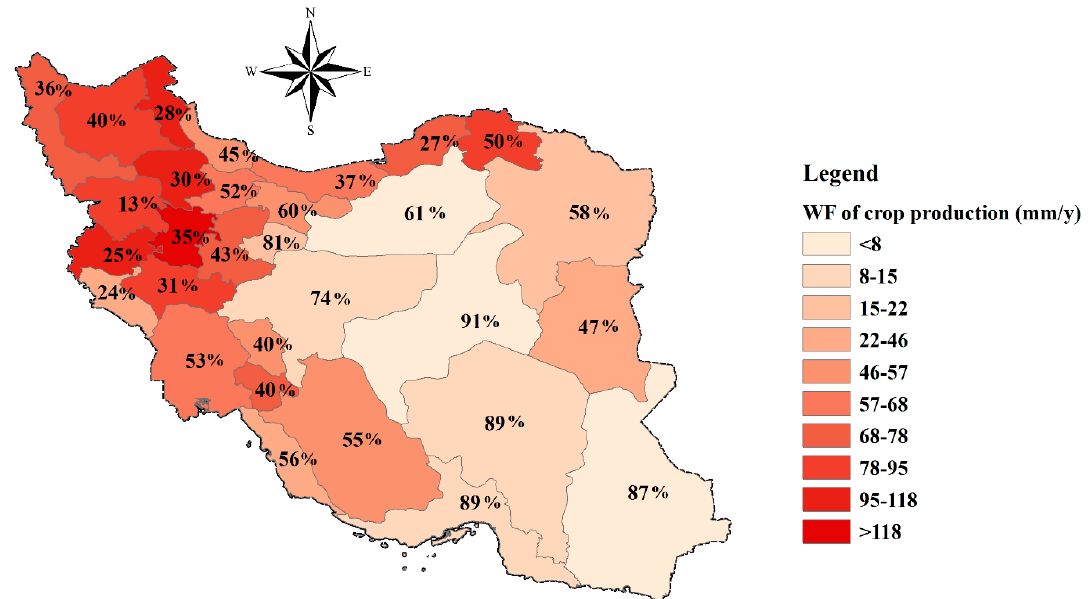
Figure 5. The 30-year average WF of Iranian crop production, per province. The WF in mm · y − 1 is obtained by dividing the total WF of crop production in the province by the area of the province.